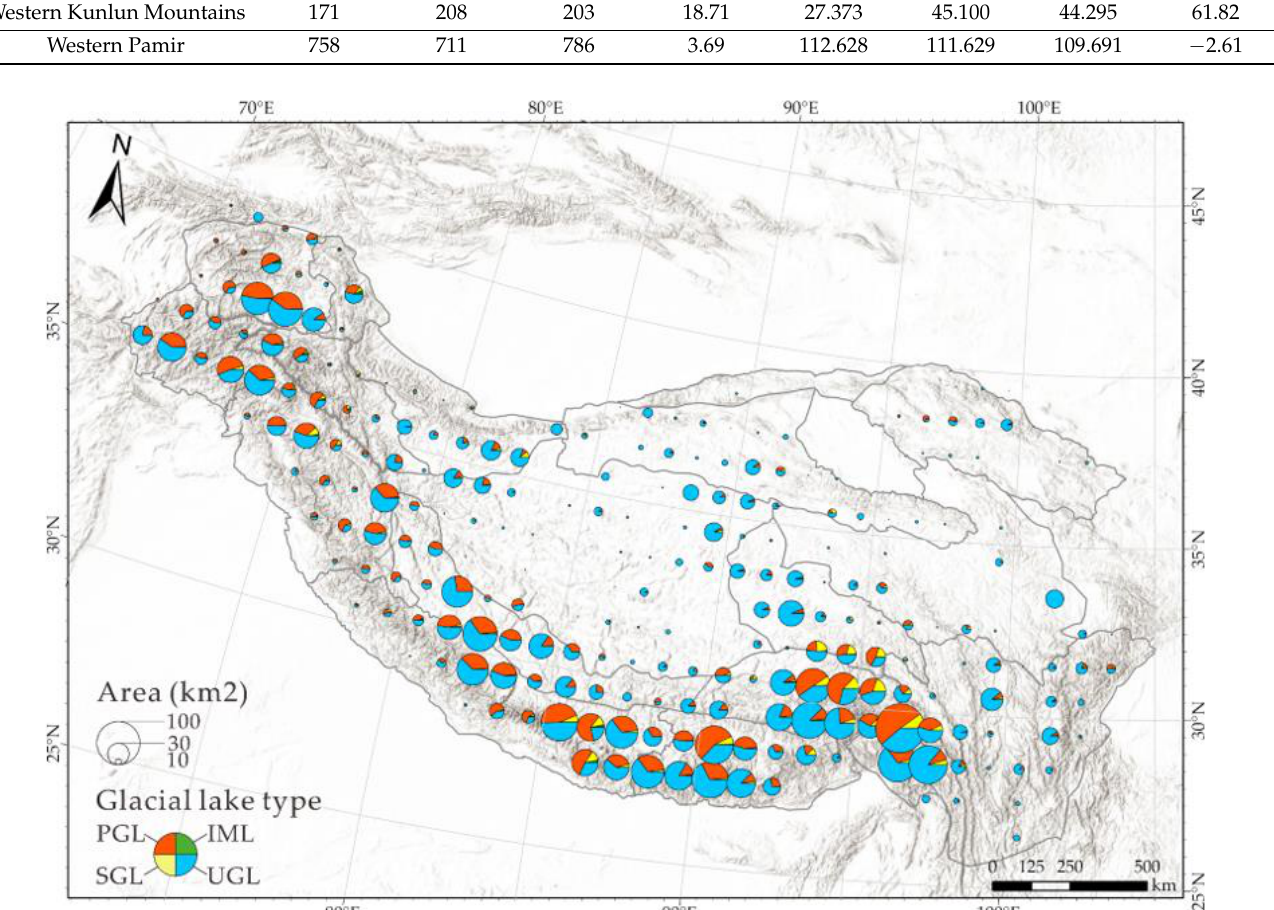
Figure 8. Area change rate of glacial lakes from the first period (1990 − 1999) to the last period (2013 − 2019) on 1° × 1° grids in various mountain regions. The circle size represents the total glacial